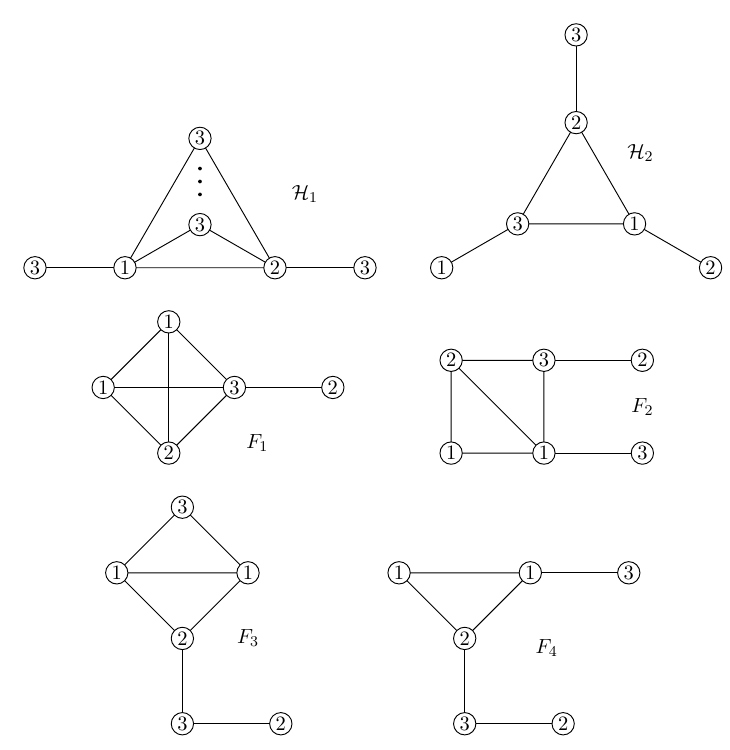
Fig. 1. Coloring graphs so that every 2K 2 receives 3